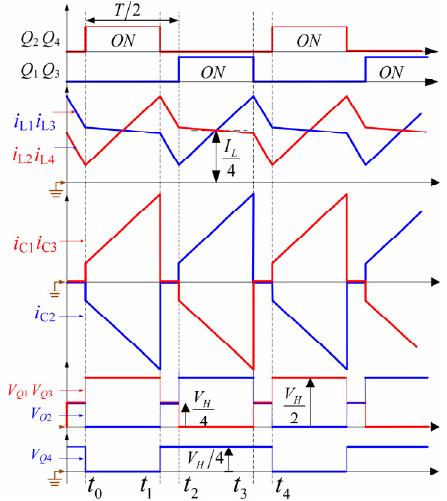
Figure 10. Operating waveforms for the CCM Buck stage.